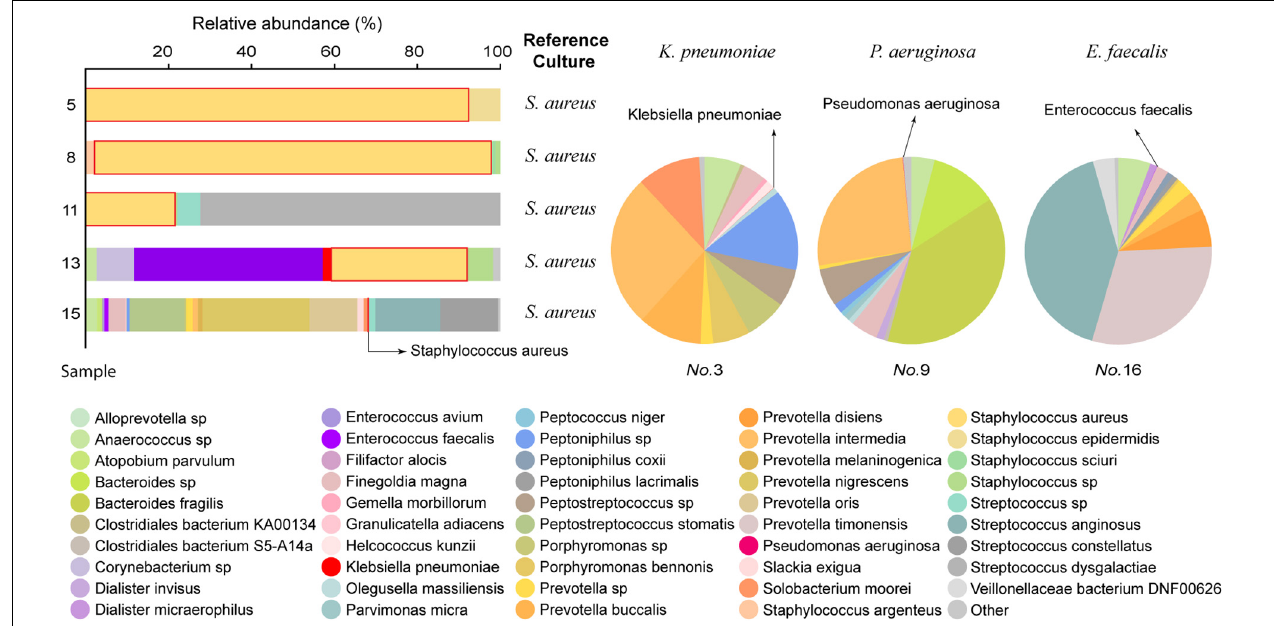
FIGURE 7 | Comparison of mNGS data to the reference culture. In the left 100% stacked columns, the column representing S. aureus is framed by a red line.